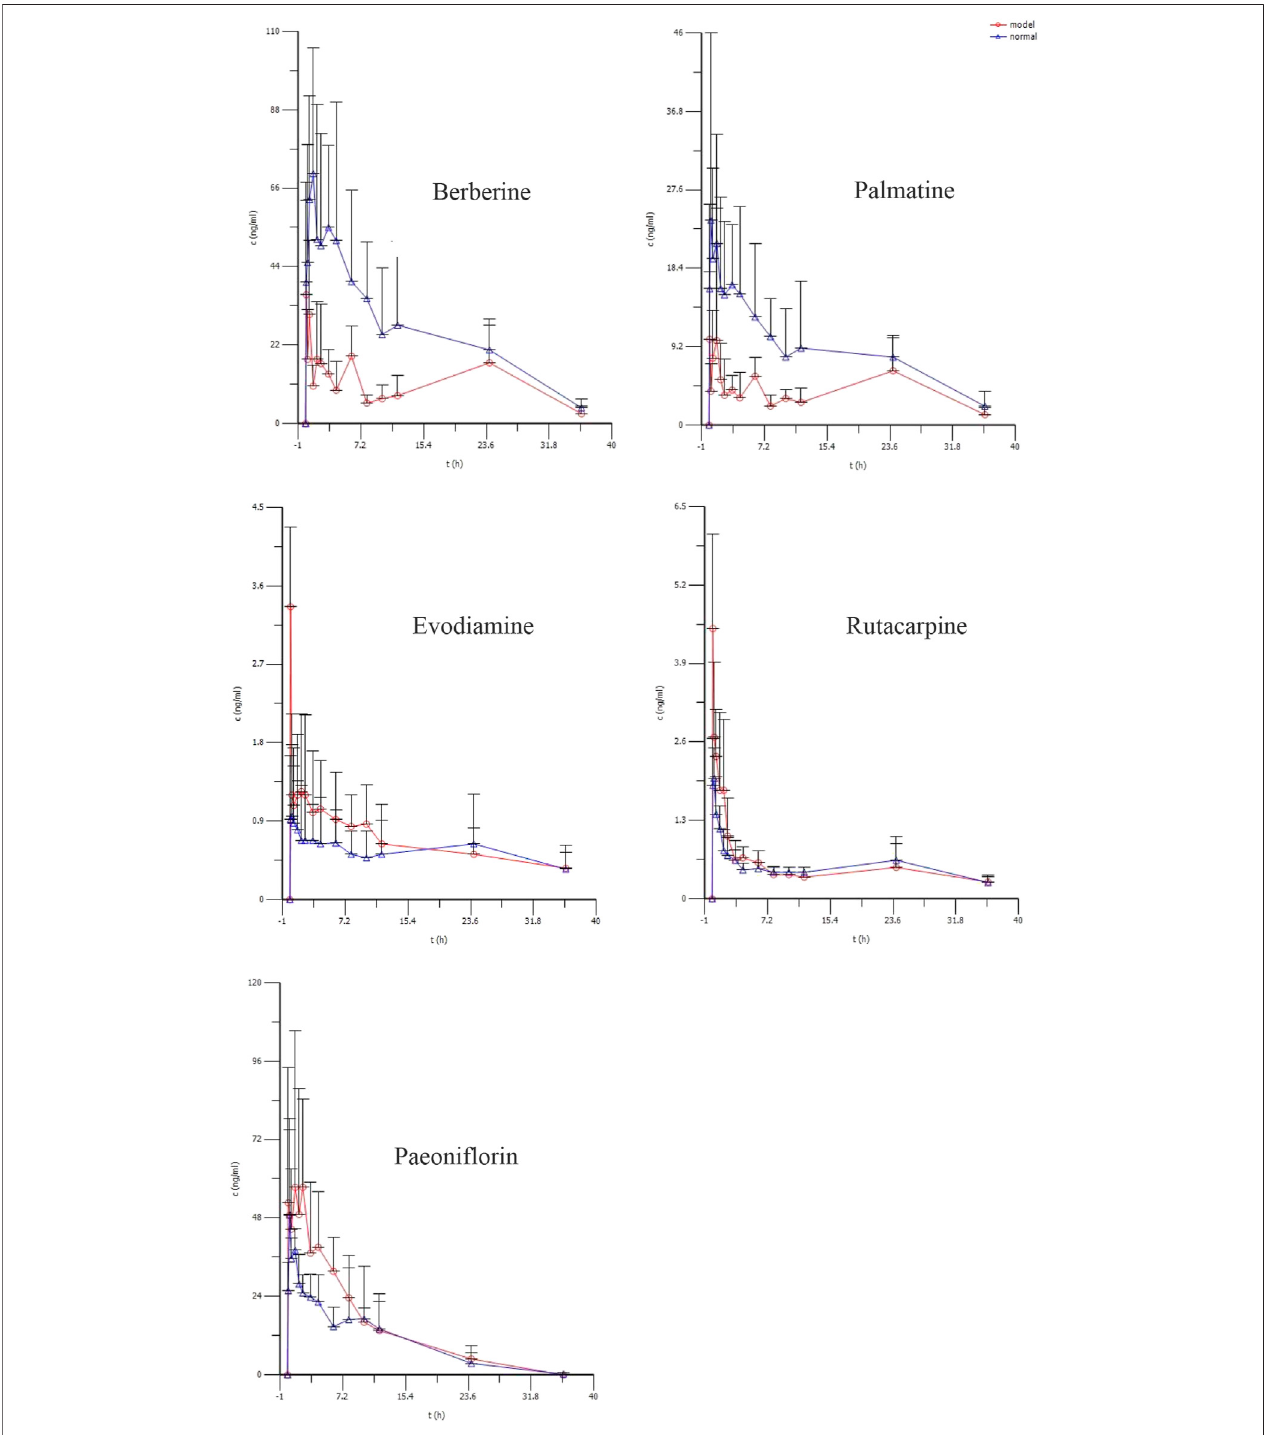
FIGURE 4 | The mean plasma concentration (ng/ml) of berberine, palmatine, Evodiamine, rutacarpine, and paeoni fl orin vs. time (h) pro fi les after multiple doses of oral administration of WJW Extract (629.6 mg/kg) with the equivalent dose of 88.4 mg/kg, 21.1 mg/kg, 0.22 mg/kg, 0.28 mg/kg, 25.1 mg/kg for berberine, palmatine, evodiamine, rutacarpine, and paeoni fl orin respectively in normal and CVH-IBS model rats. Values were expressed as mean ± SD ( n = 5).